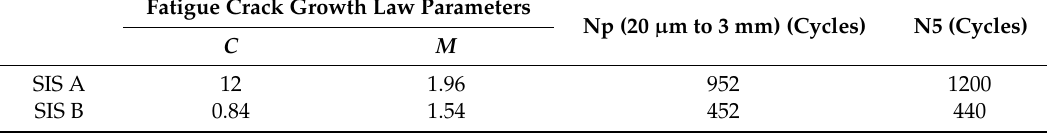
Figure 13. Striation spacing as a function of the strain intensity factor range ∆ K ε for different signals in PWR environment. Table 5. Estimated fatigue lives as compared to experimental data for fatigue testing with SIS A and SIS B signals in PWR environment (The value of C is determined for da/dN expressed in m/cycle and ∆ K ε in m 1/2 ).